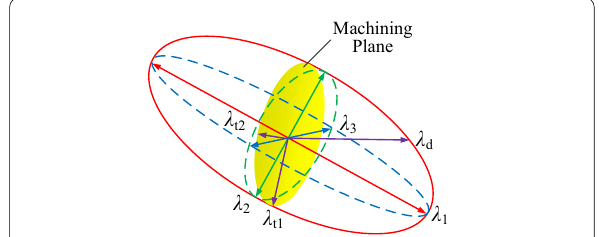
Figure 4 Stiffness